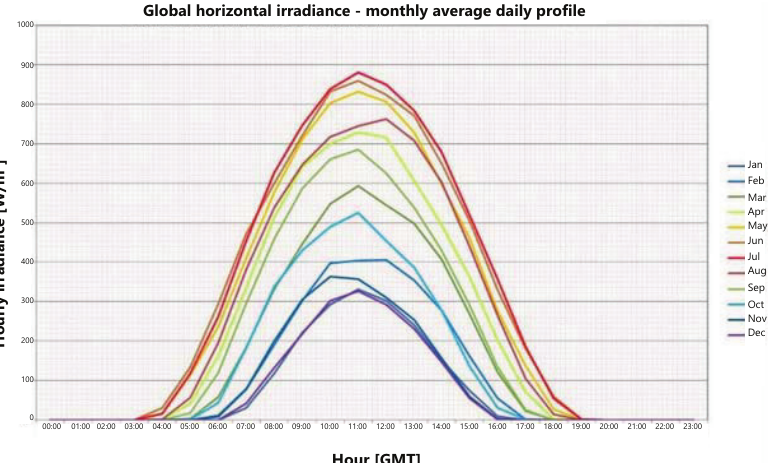
Global horizontal irradiance - monthly average daily profile